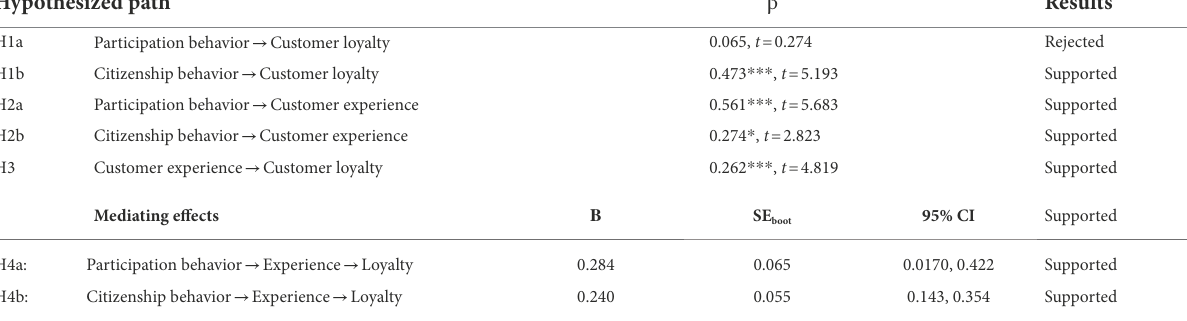
TABLE 6 Empirical results of proposed